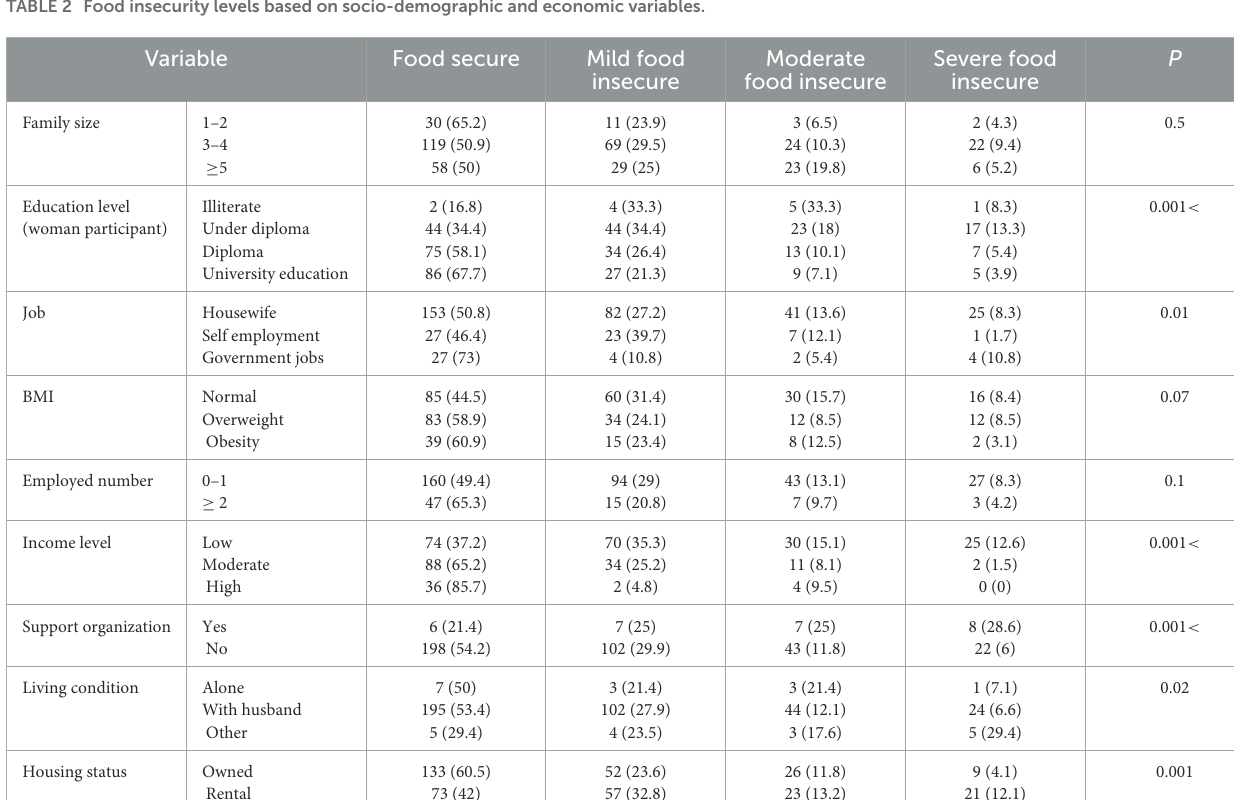
TABLE 2 Food insecurity levels based on socio-demographic and economic